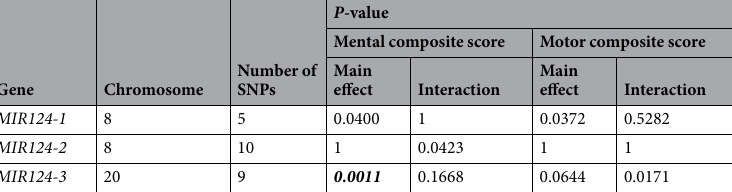
Table 3. Association of miR-124 SNP with infant mental and motor composite score in Bangladesh cohort a . a Using the Generalized Higher Criticism statistic, we aggregated the individual SNP test statistics for main effects and interaction for a total of 12 additional tests. A Bonferroni-corrected significance threshold of 0.05/12 = 0.0042 was used for region-based tests of